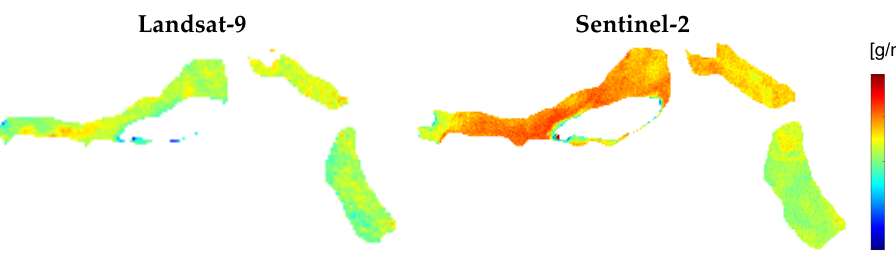
Figure 11. TSM maps derived from Landsat-9 and Sentinel-2 imagery in Lake Mantova.